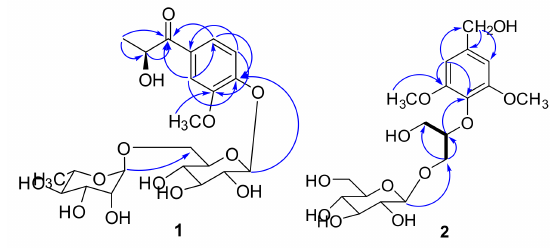
Figure 2. Key HMBC correlations of compounds 1 and 2 .